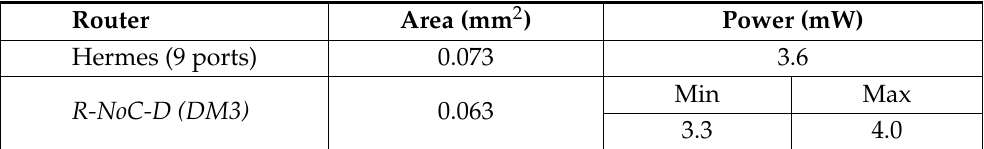
Table 5. Comparison of Hermes and R-NoC-D routers.